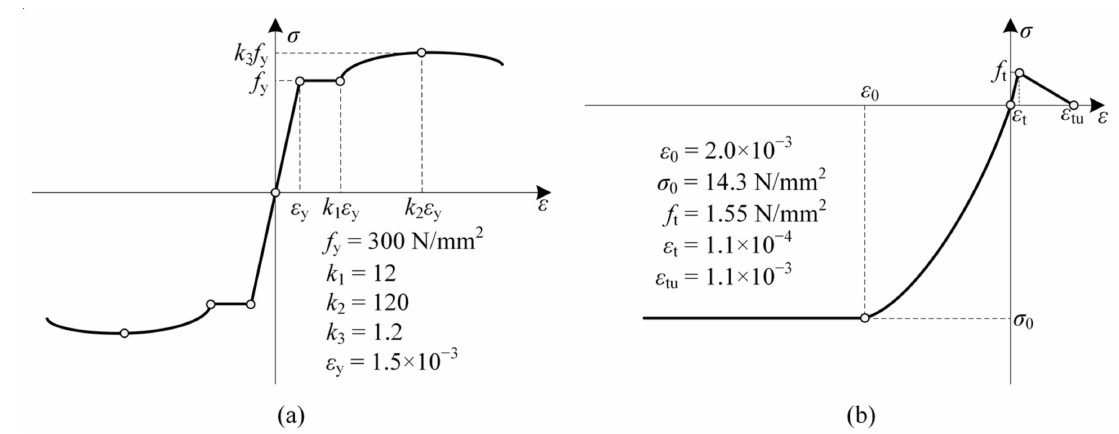
Figure 11. Skeleton curve of the stress–strain constitutive law used for steel and concrete. (( a ) Stress − strain relation of steel; ( b ) Stress − strain relation of